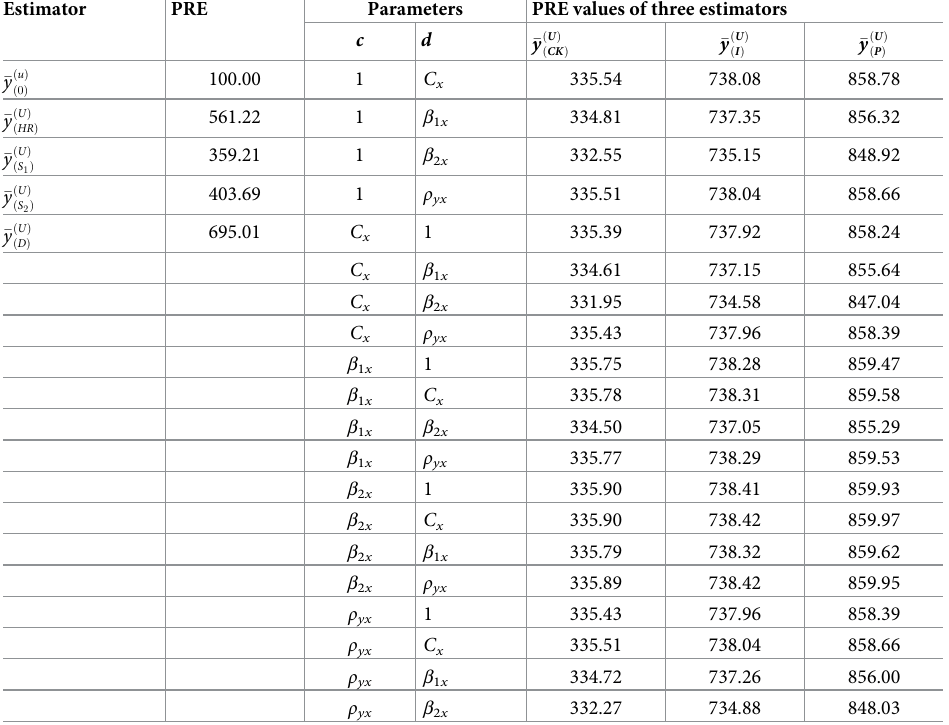
Table 1. Results of different estimators for Population